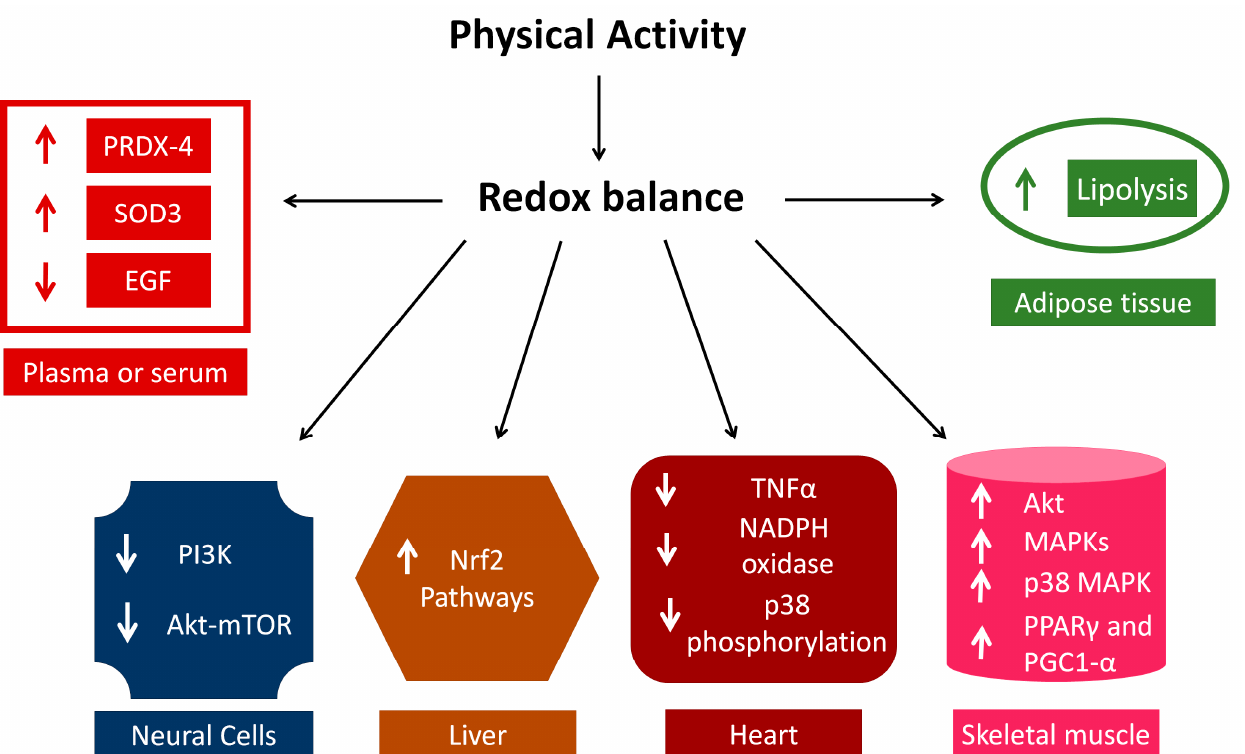
Figure 2. Schematic representation of the molecular pathways involved in redox regulation by physical activity. In plasma and serum, the effect of physical activity on redox balance is exerted through the increase of SOD3 and PRDX-4 and the decrease of EGF; in neural cells, a decrease of PI3Kinase/Akt-mTOR is observed; in liver cells, Nrf2 pathways are activated; in the heart, the effect of physical activity is associated with a decrease of TNF-alpha and NADPH oxidase, and p38 phosphorylation; in skeletal muscle, Akt, MAPKinases, PPARgamma, PGC-1 alpha and Nrf2 are up-regulated; in adipose tissue, lipolysis is activated by physical activity.